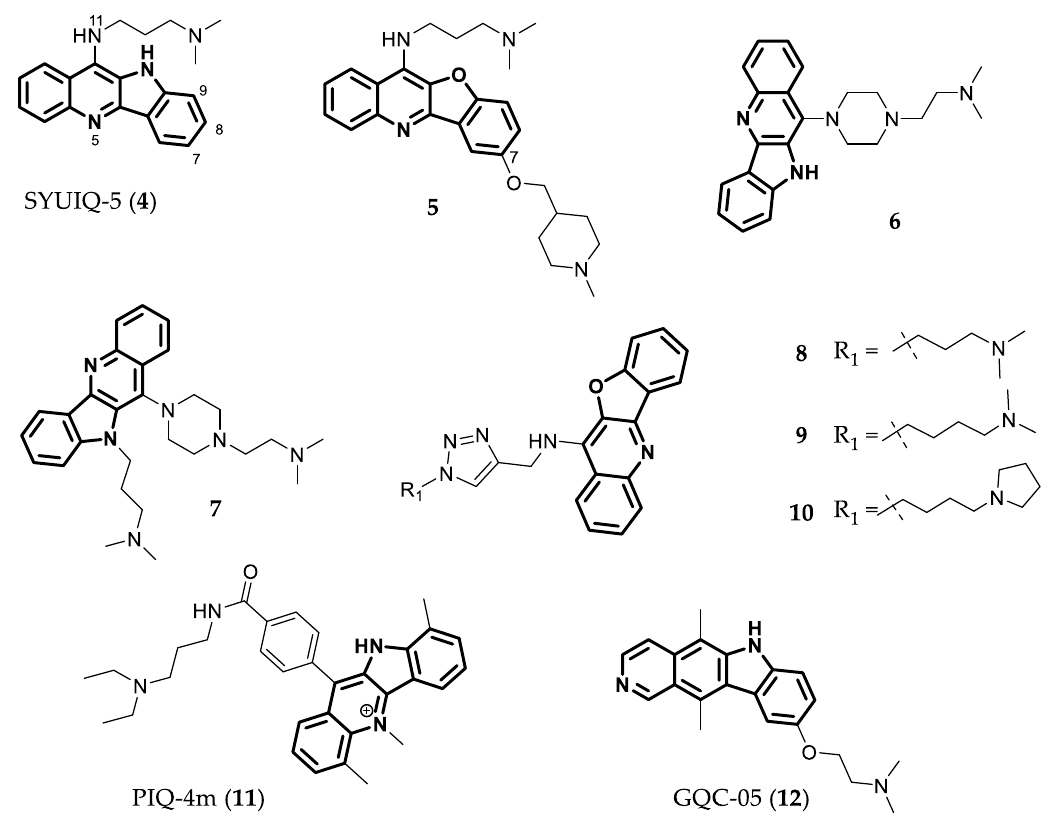
Figure 5. Structures of tetracyclic compounds: indoloquinolines 4 , 6 , 7, and 11 , bioisosters 5 and 8 – 10, and indoloisoquinoline 12 .